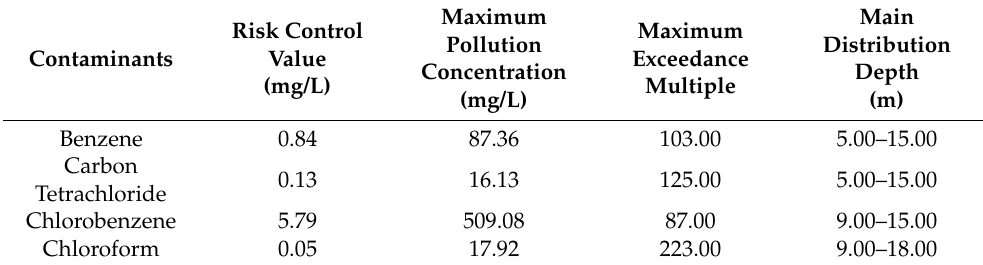
Table 1. Contaminant concentrations in groundwater-monitoring